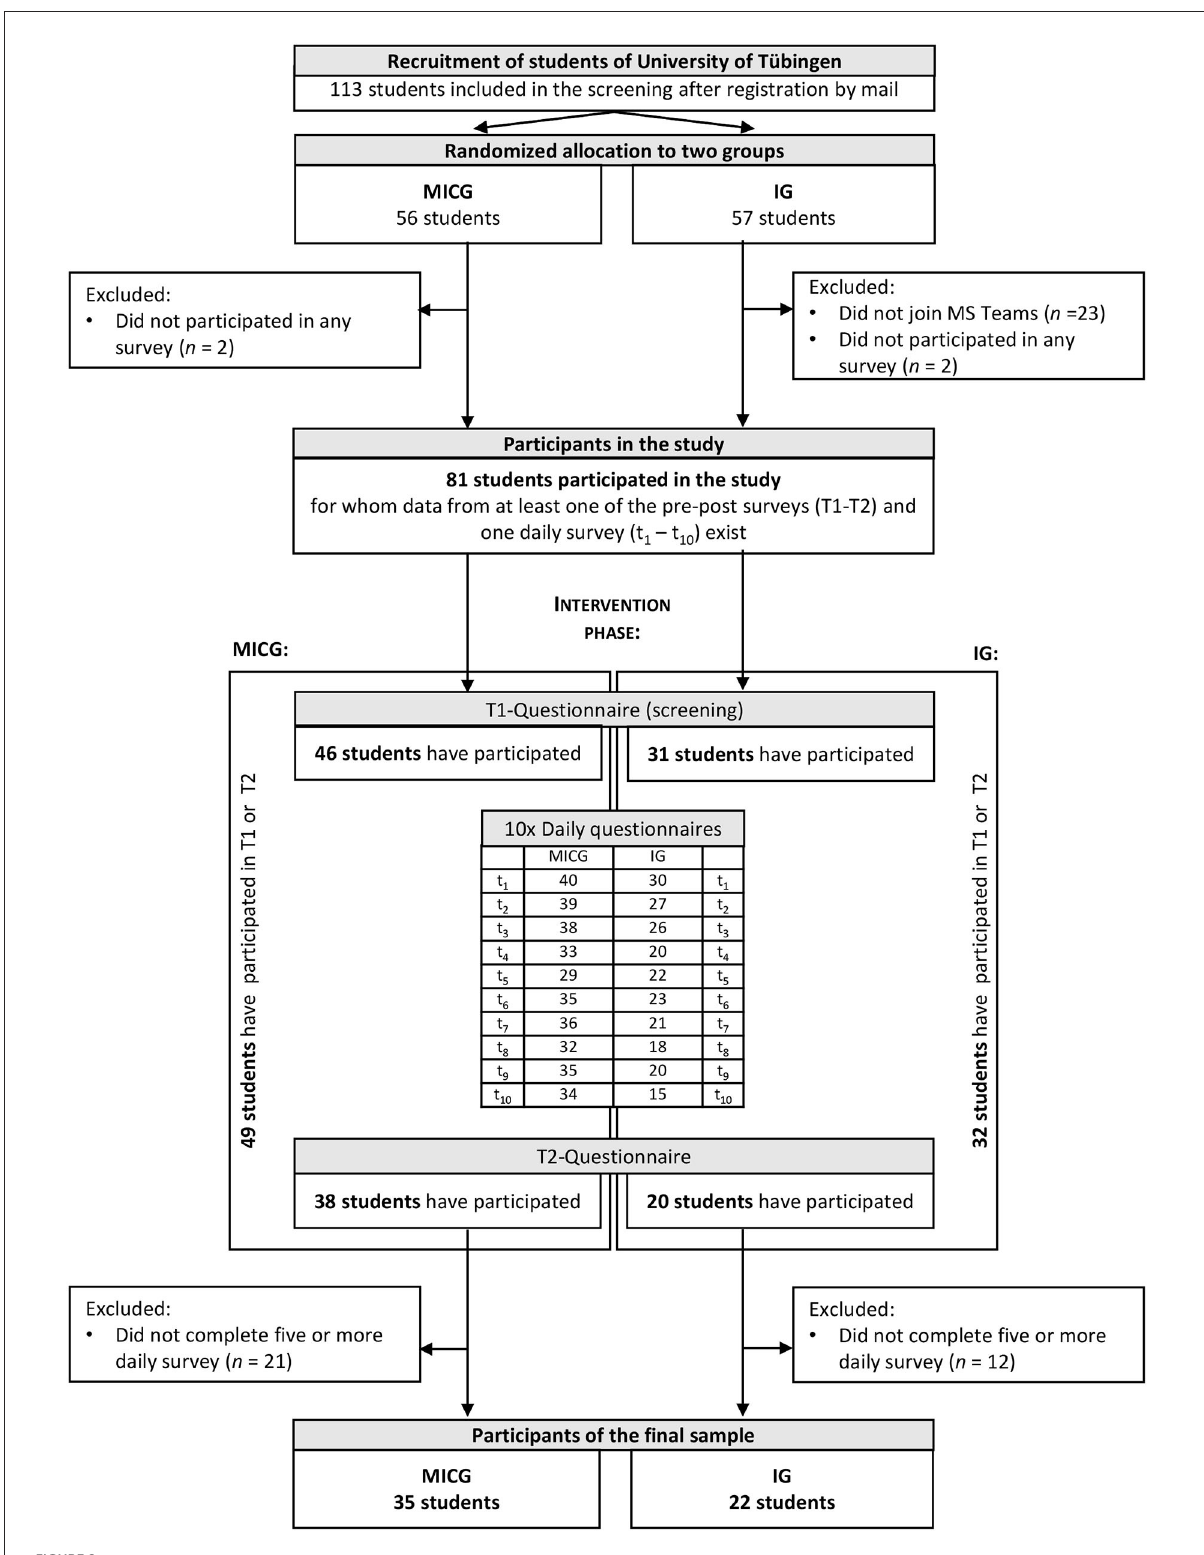
FIGURE2 Flow diagram of the study participants (MICG, minimal intervention control group; IG, intervention